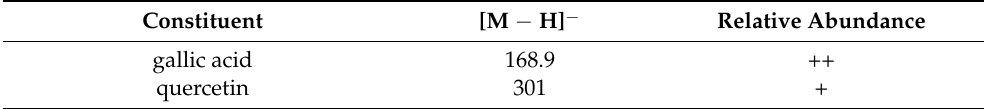
Table 1. Constituents identified in the polyphenol-enriched fraction extracted from Myrtus communis and their relative